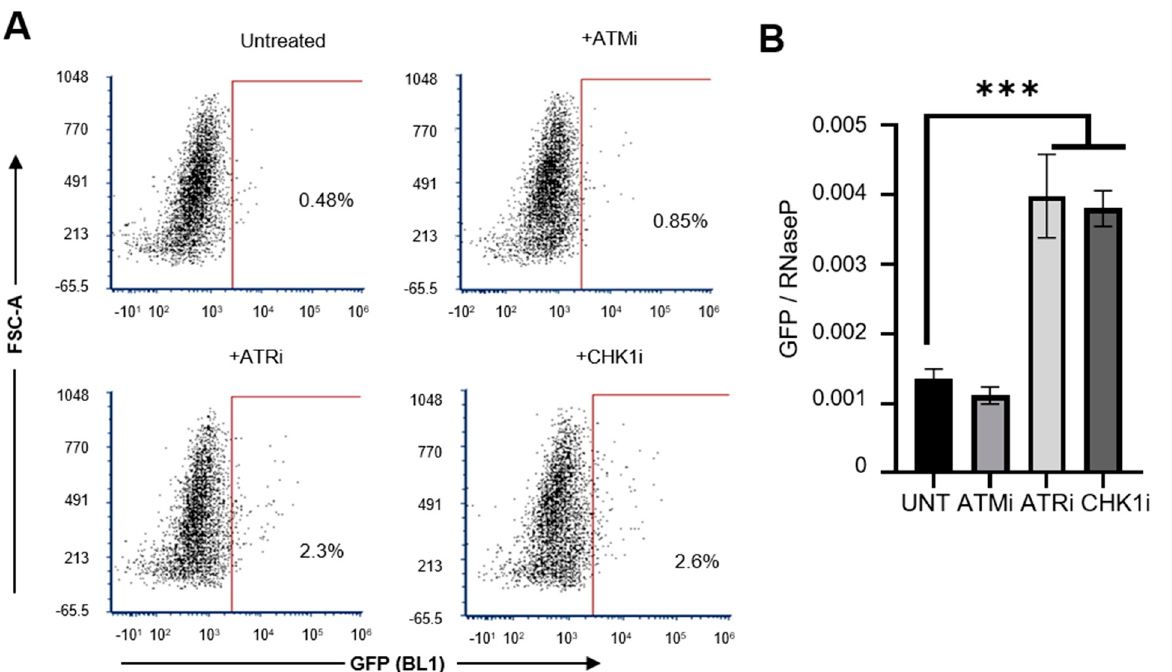
Figure 4. Regulation of active retrotransposition in Huh7 cells by DDR response pathways. Level of L1 retrotransposition was measured using FACS and Taqman qPCR assays, following the transfection of Huh7 WT cells with the GFP-LRE3 plasmid, at the basal level or upon treatment with the indicated DDR pathway inhibitors. Numbers on the dotplots represent % EGFP positive cells (representative of cells undergoing active retrotransposition). The positive gate is marked by red lines. ( A ). Quantification of GFP insertions in the genome using RNaseP as a control, n = 3 technical replicates ( B ). *** p < 0.001, one-way ANOVA with multiple comparisons. Key: FSC-A = Forward Scatter Area; DDR = DNA Damage Response; qPCR = Quantitative Polymerase Chain Reaction; ATMi = Ataxia Telangiectasia Mutated kinase inhibitor; ATRi = Ataxia-Telangiectasia and Rad3-related kinase inhibitor; CHK1i = Checkpoint kinase 1 inhibitor; UNT = Untreated.